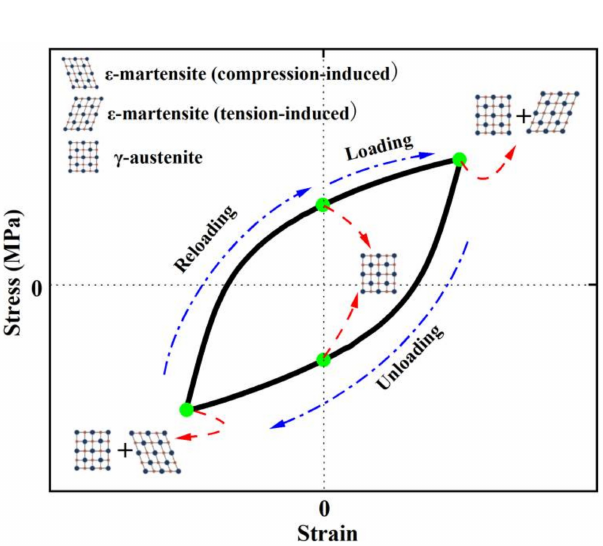
Figure 11. Phase transformation during cyclic tension-compression process for